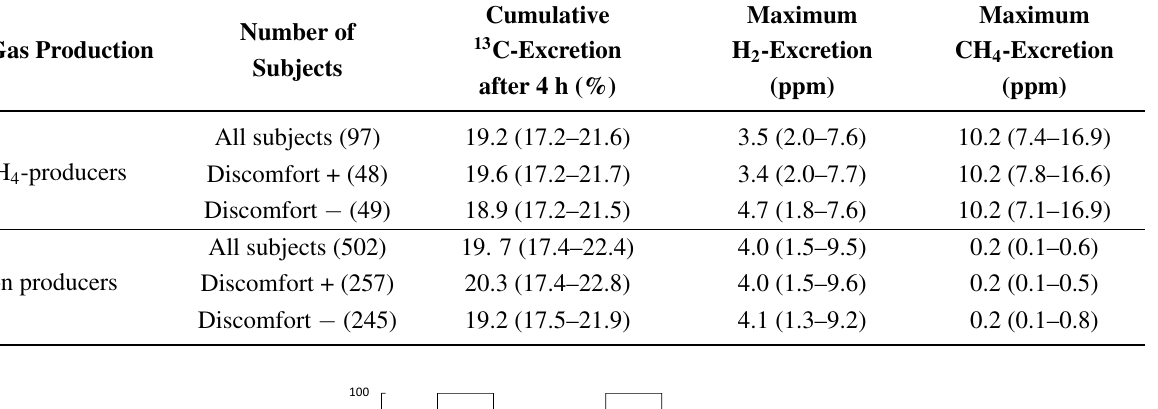
Table 4. 13 CO levels below 20 ppm.